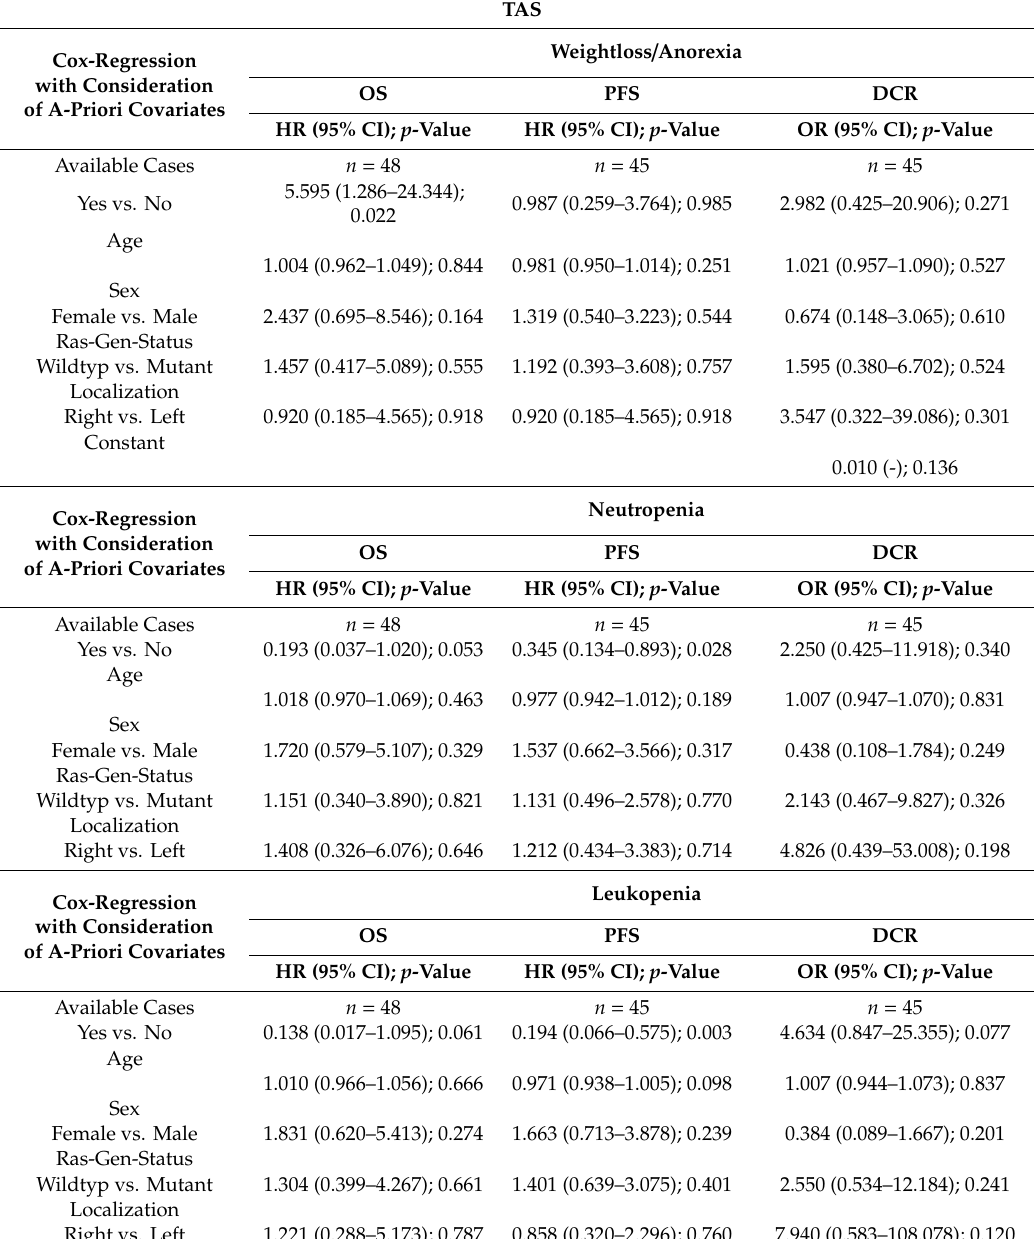
Table 3. Association between progression-free survival (PFS) / overall survival (OS) / disease control rate (DCR) and adverse events with consideration of a-priori covariates in trifluridine /